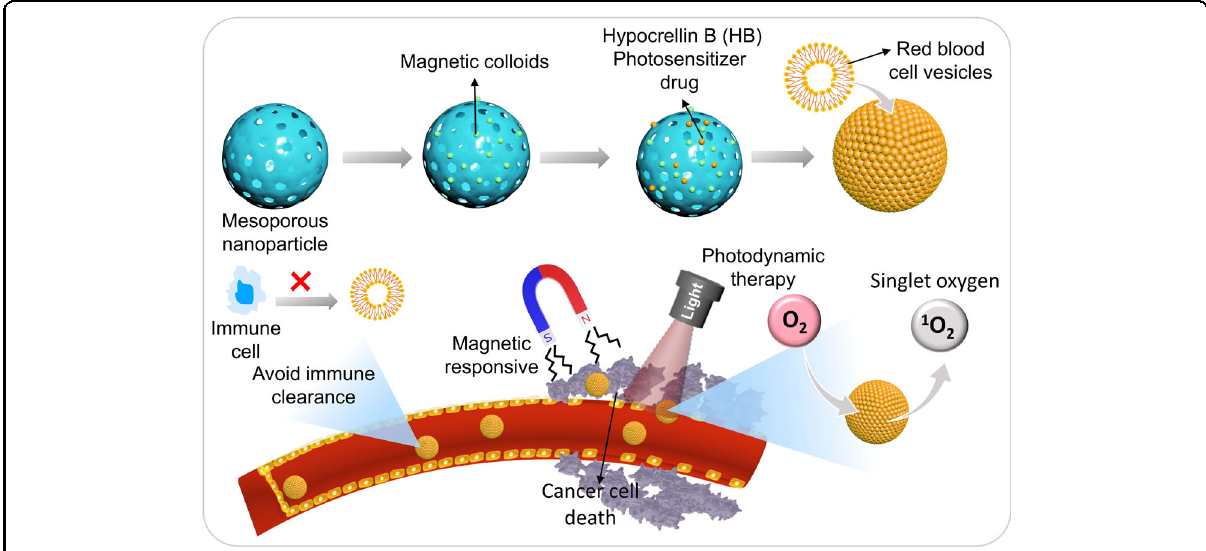
Fig. 14 Strategy for avoiding the immune clearance of magnetic-responsive mesoporous nanoparticles. Integral membrane proteins in red blood cell membranes act as self-markers, which avoid immune clearance and extend blood circulation.